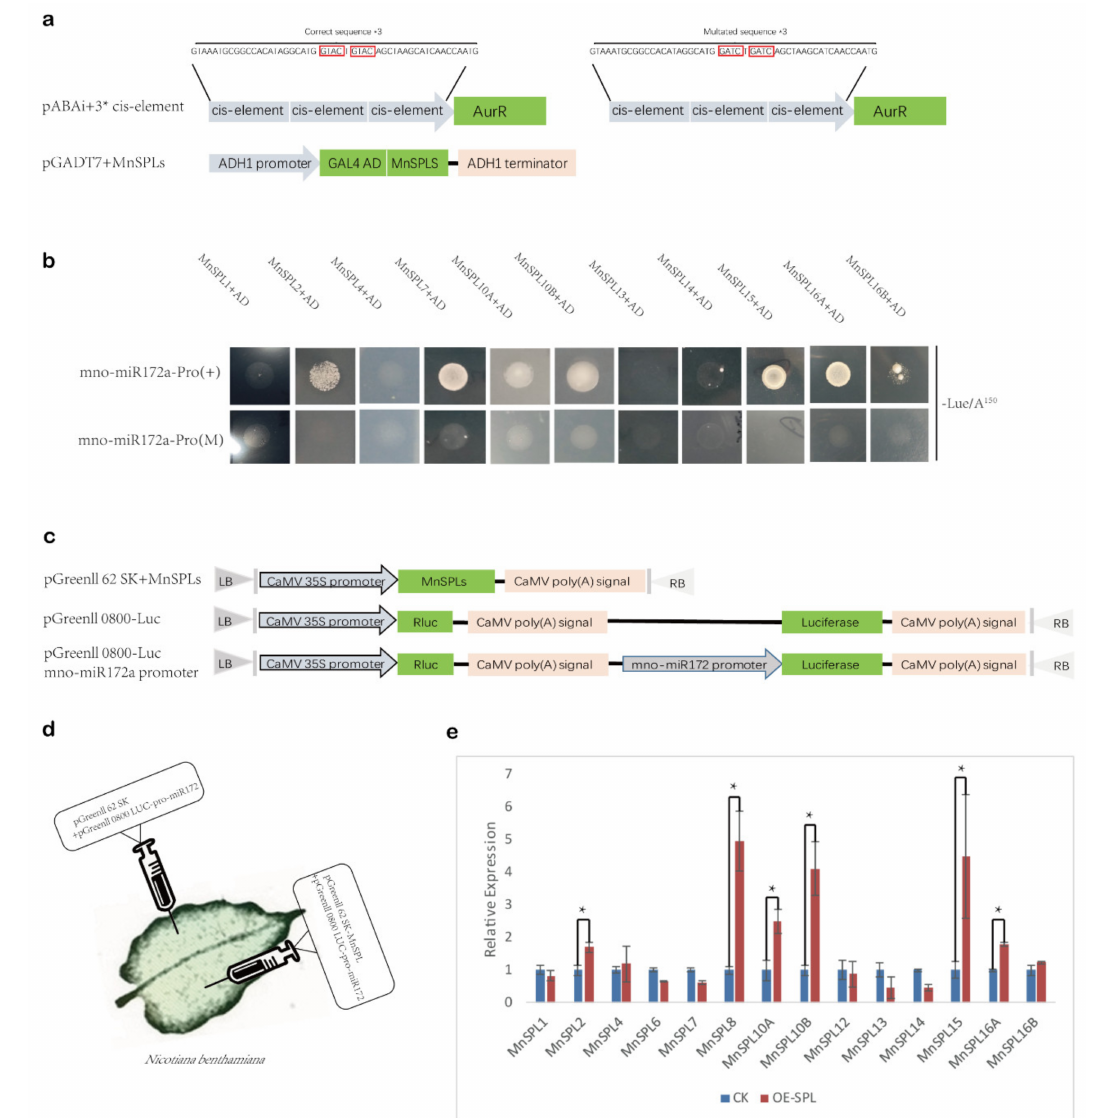
Figure 7. MnSPLs promote miR172 expression in mulberry. ( a ) Schematic of plasmids used in yeast one-hybrid assays. Red boxes show the sites of cis -elements in the promoter of miR172, which can be recognized by MnSPLs. ( b ) Yeast one-hybrid assay identified the interaction between MnSPLs and the promoter of miR172. (+) means a correct sequence of the cis -element. (M) means a mutated sequence of the cis -element. ( c ) Schematic of plasmids used in dual-luciferase assays. ( d ) Schematic diagram of dual-luciferase assays. ( e ) Dual-luciferase assays identified the interaction between MnSPLs and the promoter of miR172. CK: control check. OE-SPL: over-expression of SPL genes. Values represent the mean ± SD from three biological replicates and were statistically analyzed (independent-samples t -test): *, p <